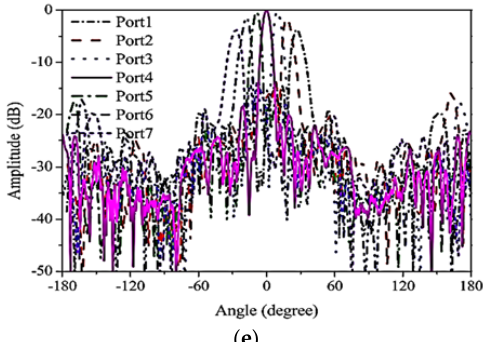
Figure 17. ( a ) Side view of seven ‐ element antenna array combined with EM lens. ( b ) Top view of the seven ‐ element SIW fed by a stacked patch antenna array. ( c ) Photograph of the lens integrated array antenna prototype. ( d ) Experimented and simulated 10 ‐ dB impedance bandwidth. ( e ) Measured scan beams of the proposed lens ‐ fed phased ‐ array antenna (Redrawn from [39]).